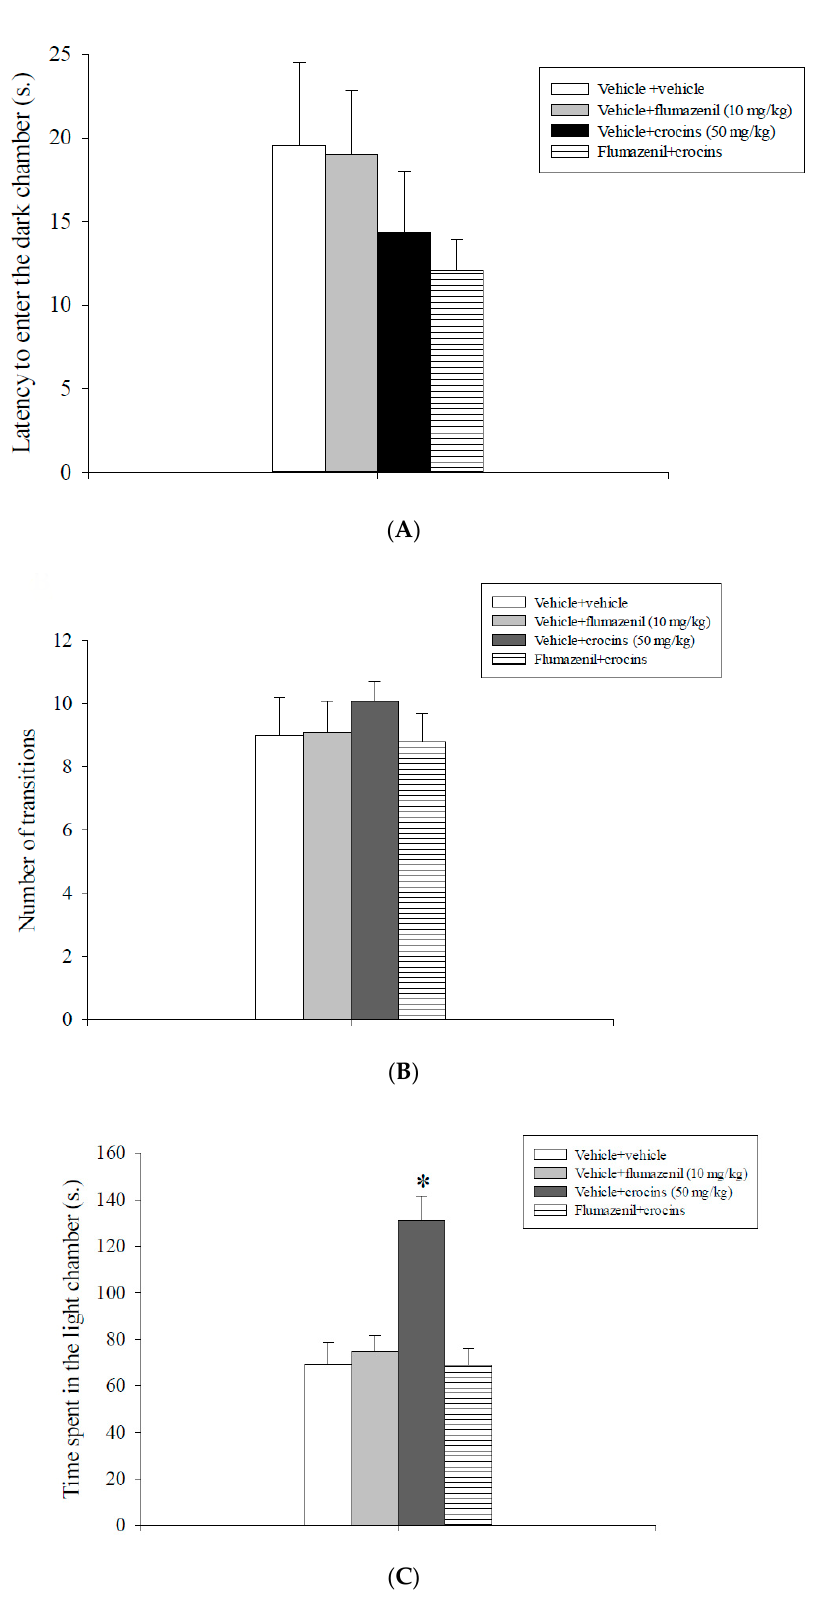
Figure 1. Light / dark box test. Crocins and flumazenil were injected intraperitoneally 60 and 30 min respectively before testing. The graphic illustrates the means ± S.E.M. of 8 rats per experimental group. ( A ) Latency to enter the dark chamber. ( B ) Number of transitions. ( C ) Time spent in the light chamber. * p < 0.05 vs. all the other